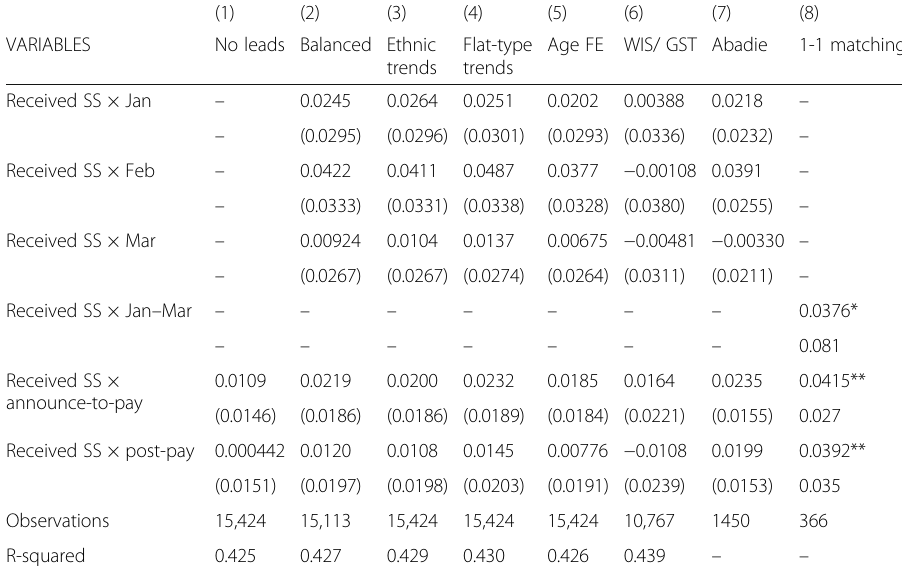
Table 19 Robustness check for impact of receiving SSS payouts on giving private cash